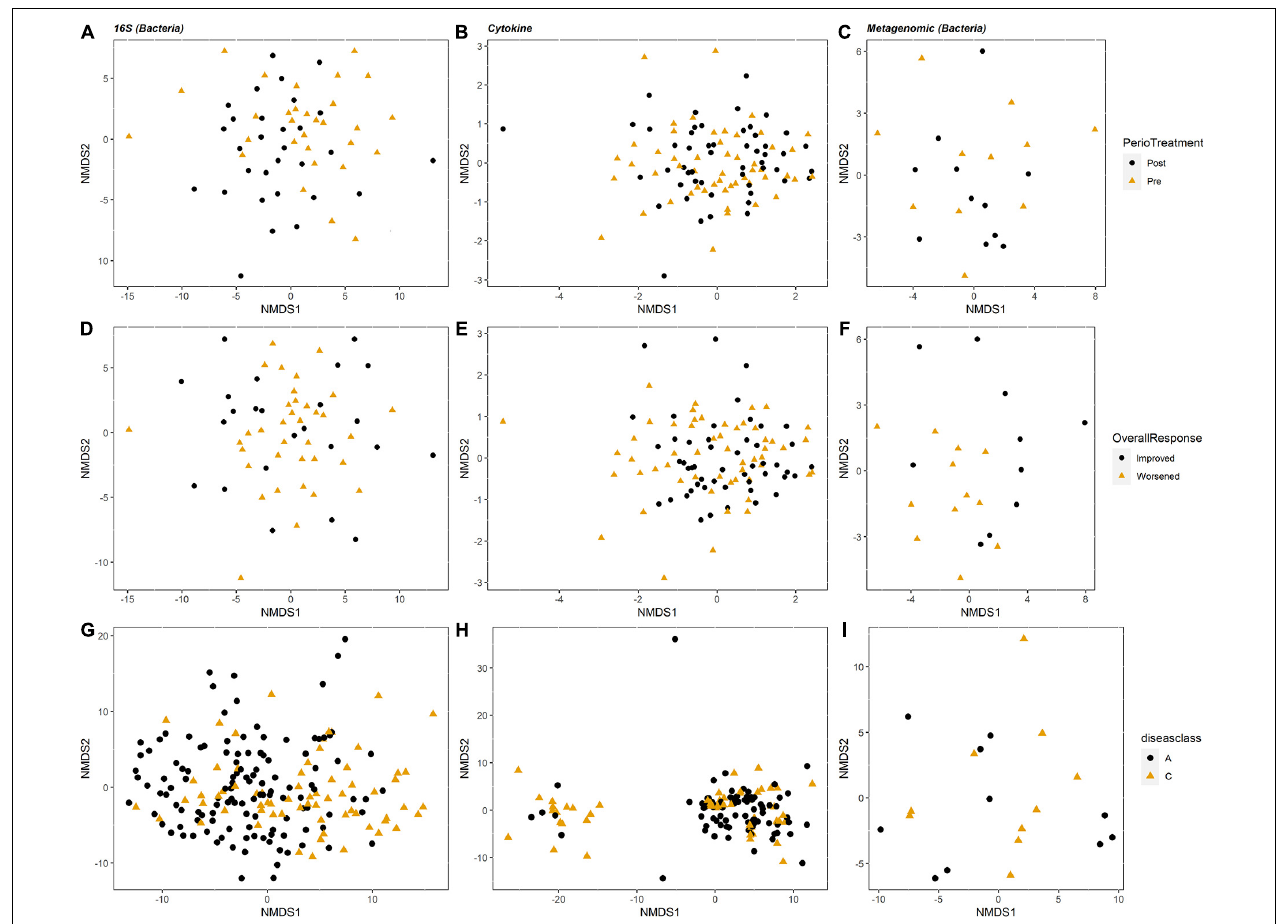
FIGURE 2 | Non-metric multidimensional scaling (NMDS) ordination plots showing clustering of the samples. For the periodontal treatment (PT) study (A–F) , columns correspond to dataset type: 16S, cytokines, and metagenomics are columns 1, 2, and 3, respectively ( n = 60, 104, and 22). The top row (A–C) is colored by periodontal treatment and the second row (D–F) colored by overall response. For the sodium hypochlorite (SHT) study (G–I) , columns correspond to dataset type: 16S, metabolomics, and metagenomics are columns 1, 2, and 3, respectively ( n = 209, 153, and 24). Plots are colored by disease